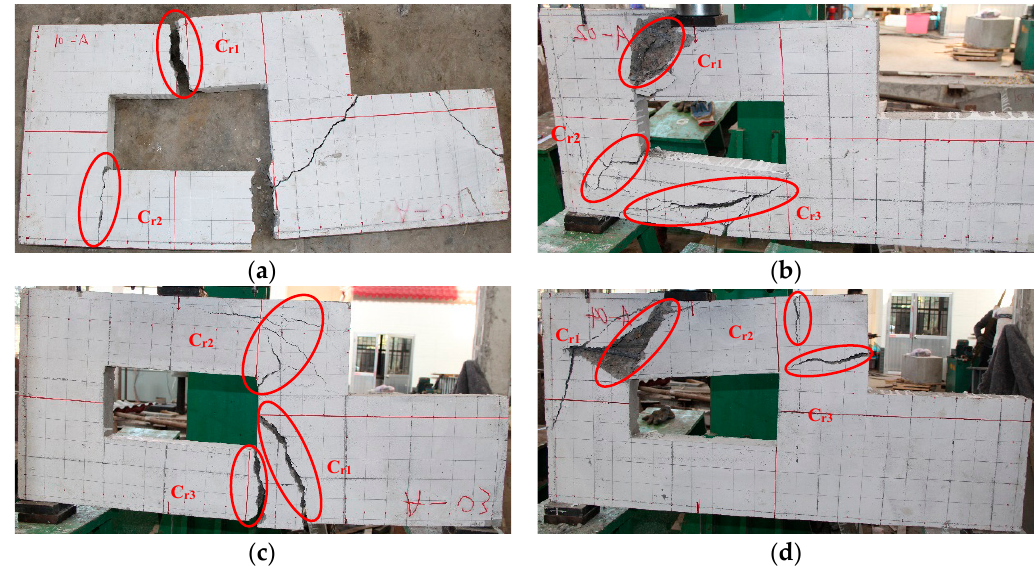
Figure 15. Failure patterns of Group A irregular concrete deep beam specimens: ( a ) specimen A-01; ( b ) specimen A-02; ( c ) specimen A-03; ( d ) specimen A-04.